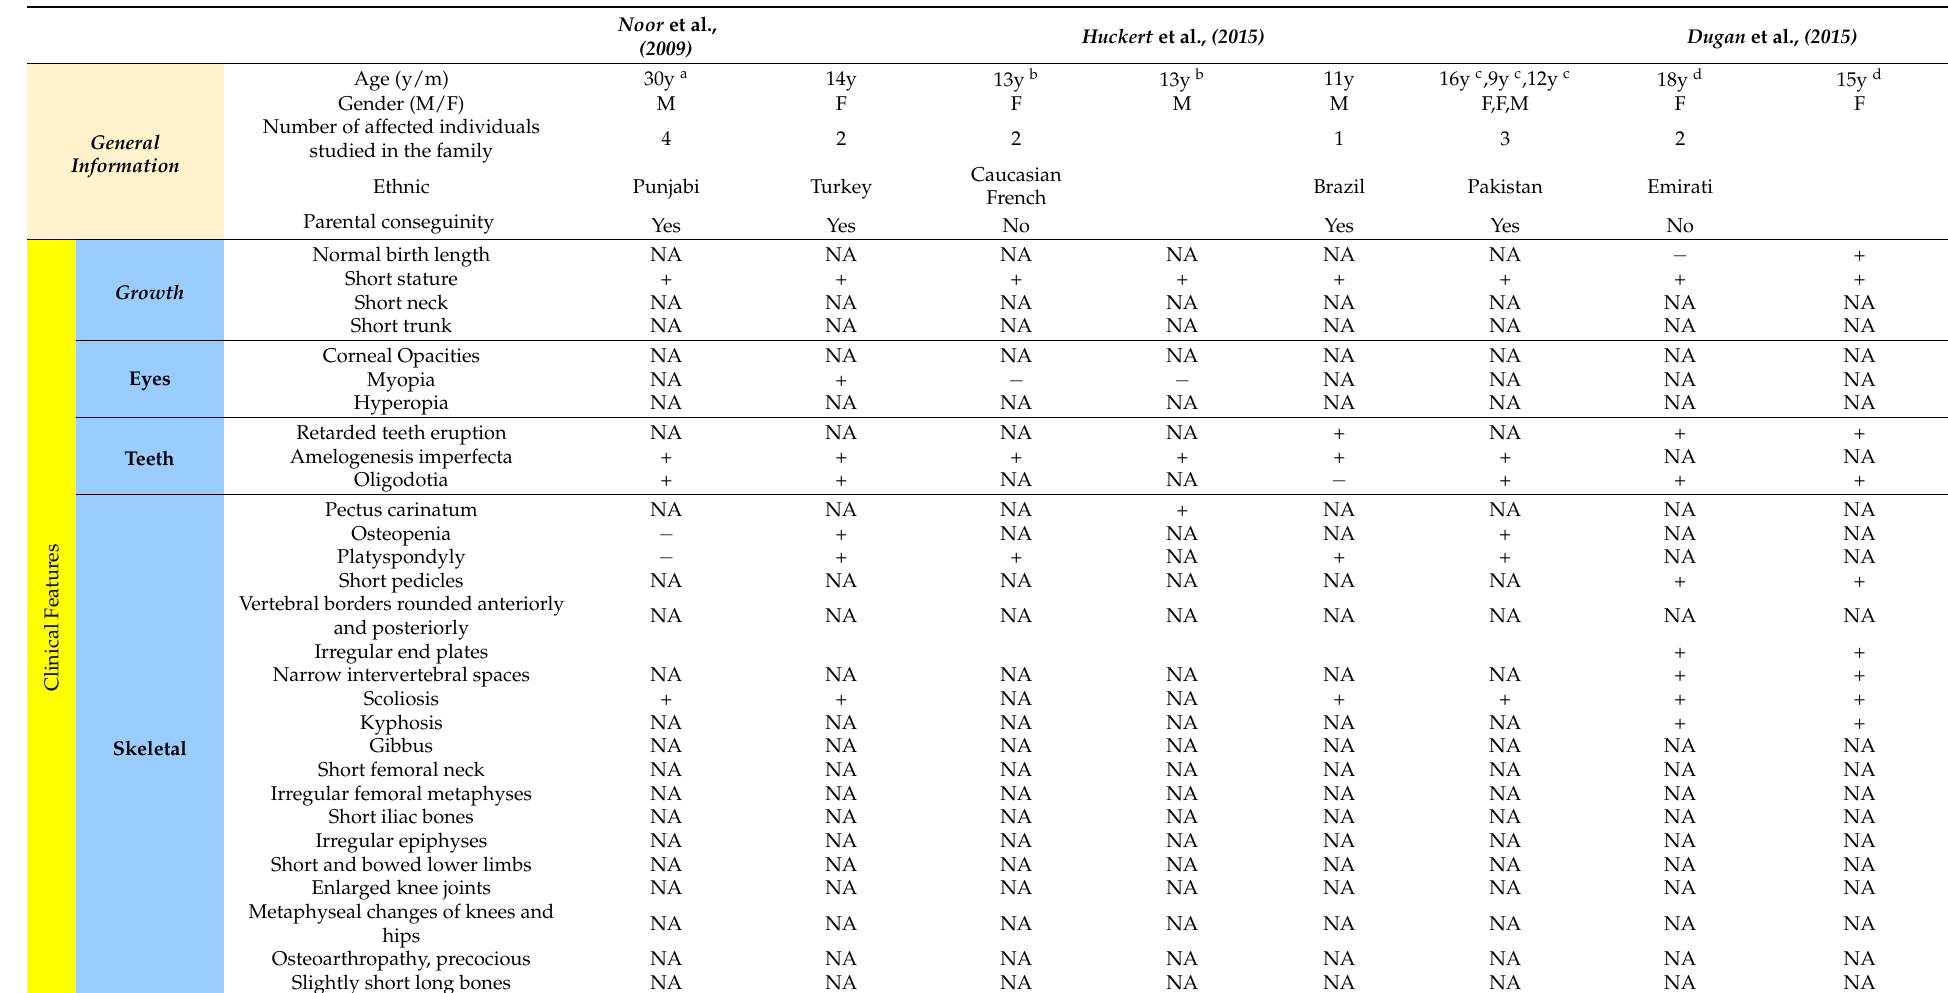
Table 2. Clinical phenotype of brachyolmia with amelogenesis imperfecta (AI) and identified disease-causing variants reported in literature. Noor et al.,